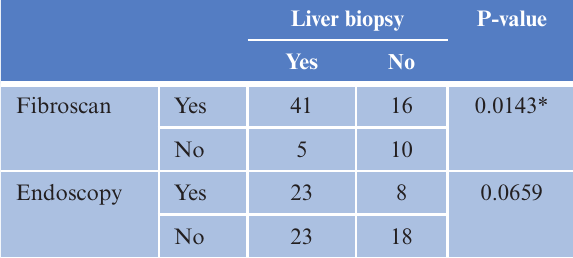
Table 2: Correlation of Fibroscan and endoscopy with liver